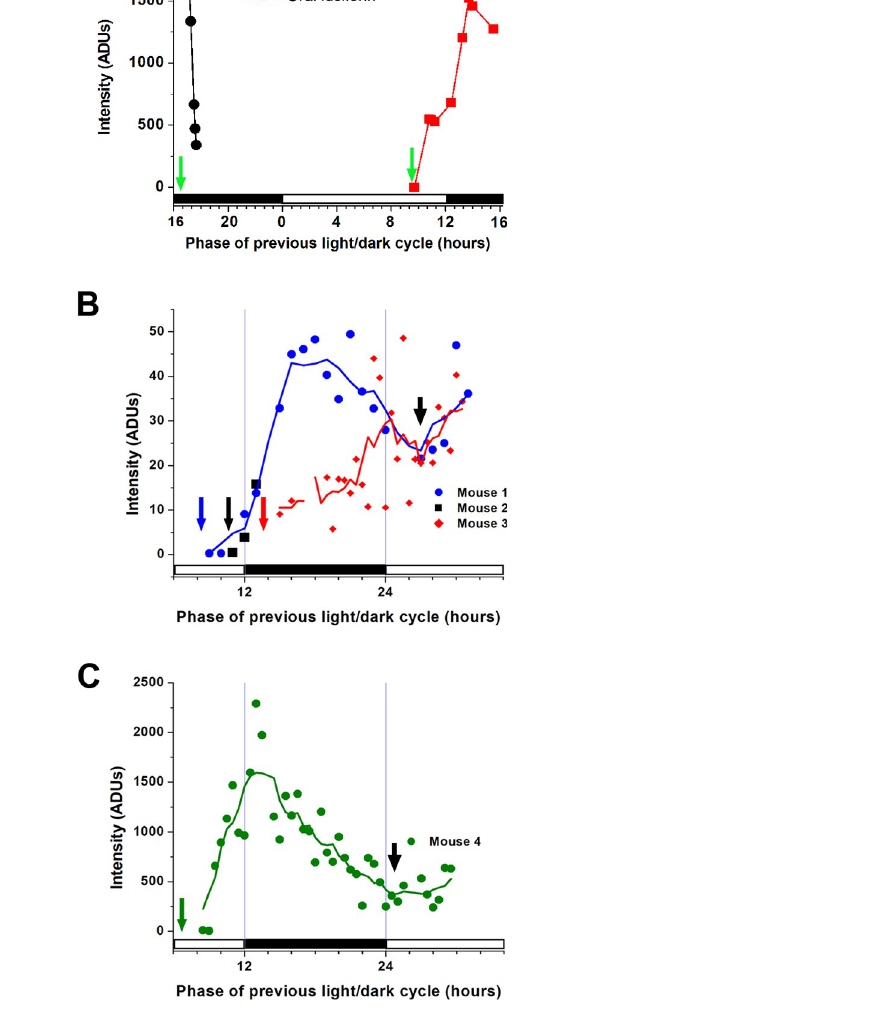
about 1 ml/hour, and it also varied across the circadian cycle with greater drinking during the time corresponding to the night of the previous light/dark cycle. We observed no aversion to drinking luciferin in apple juice or water.